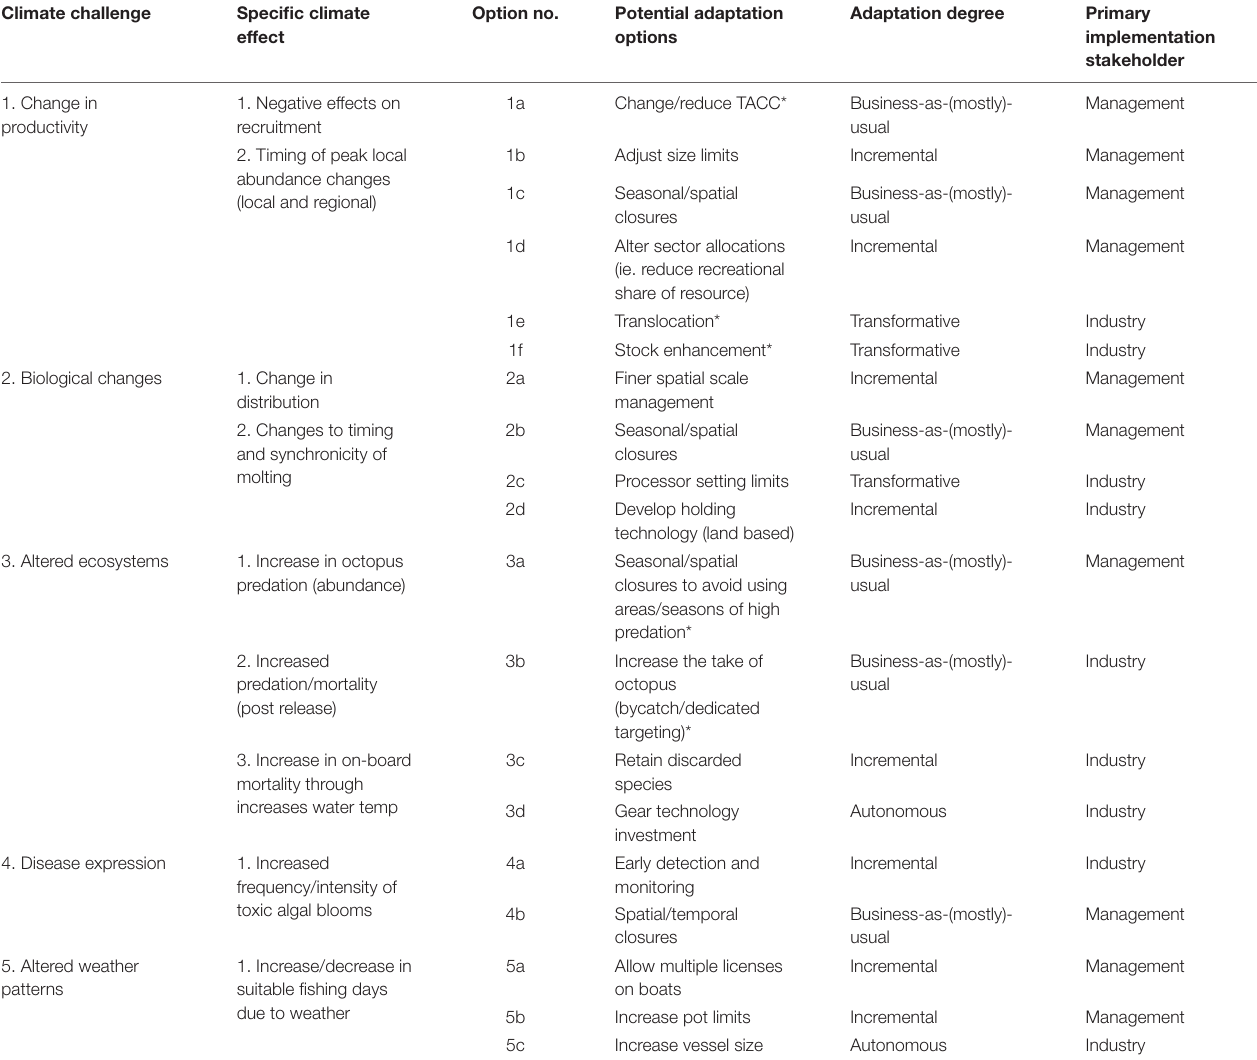
TABLE 3D | Summary characterization of adaptation options identified for Southern rock lobster. Climate